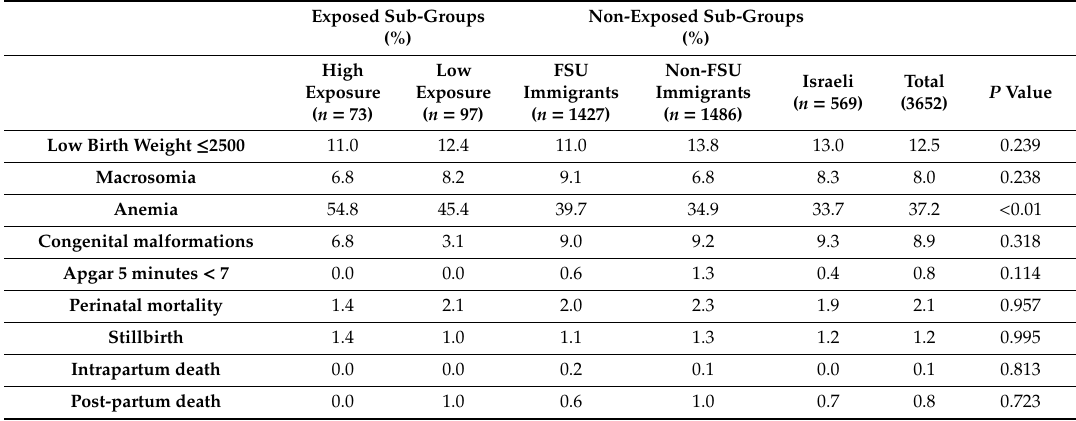
Table 3. Perinatal outcomes of the study